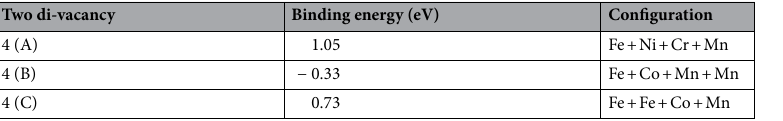
Table 4. Binding energies of the tetra-vacancy composed of two di-vacancies with different atomic vacancy formation sequences.